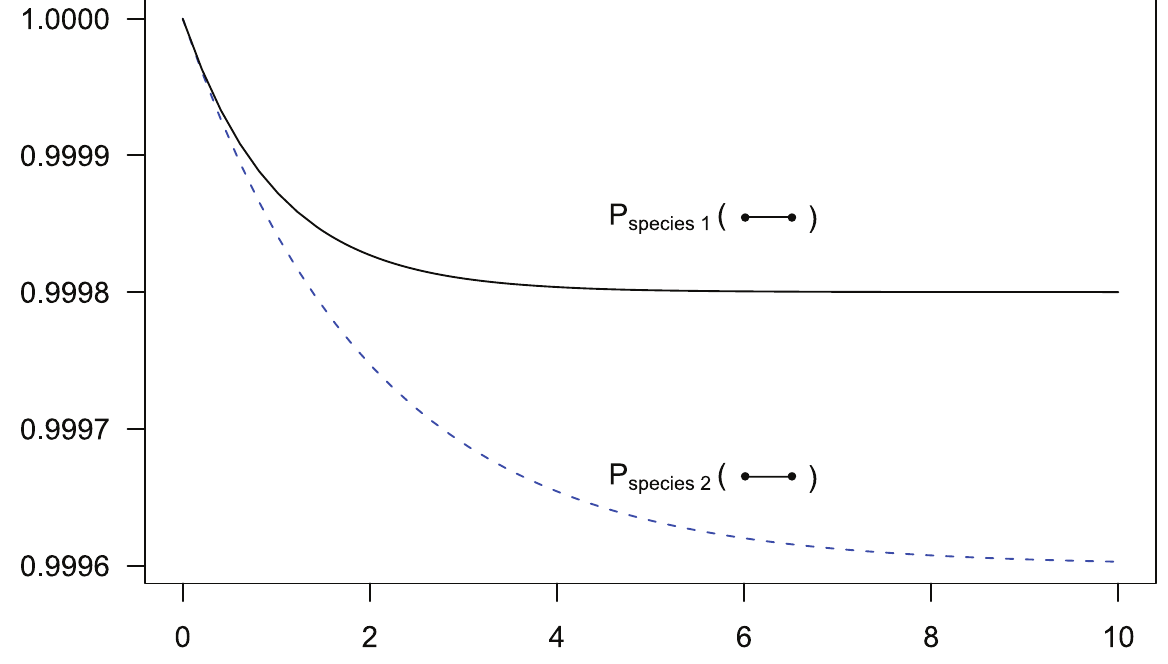
Figure 3. State probabilities for the single sequence two-nucleotide coalescent process as a function of time. The figure shows the probability of the two neighboring nucleotides being linked in the single-sequence CTMC and how this probability evolves over time. The probability for being unlinked is, of course, one minus the probability of being linked, since the CTMC has only two states. The two different lines correspond to two different coalescence rates. For population 1, the coalescence rate is set to 1 (so the x-axis is in units of 2 N e generations for this species), while for population 2 the coalescence rate is half that, corresponding to population 2 having twice the effective population size of population 1. The recombination rate is set to 2 : 10 { 4 . Assuming 2 N e of 20,000 for population 1 and 40,000 for population 2, and a generation time of 20 years, this corresponds to 1 cM/Mbp and 1 unit on the x-axis corresponds to 400,000 years. The separation time we infer for the orangutan sub-species is around 0 : 75 on the x-axis, where the system is still far from equilibrium.